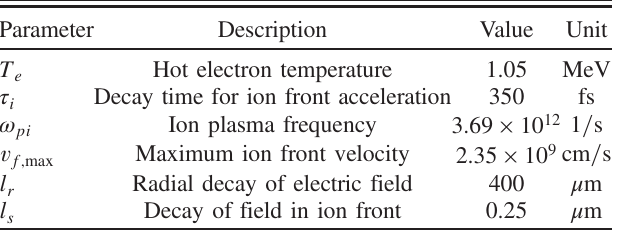
TABLE II. Variables and simulation parameters of model B and model C.